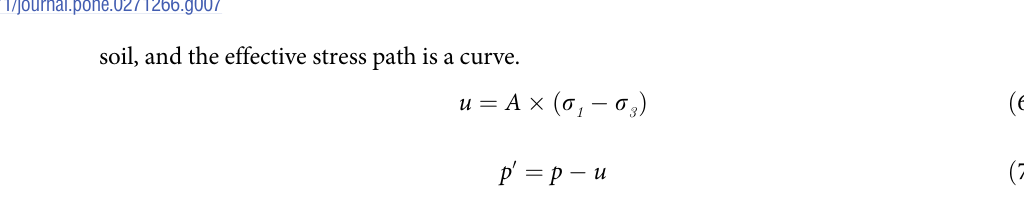
Fig 7. The relation between deviatoric stress and shear rate under different confining pressures. (a) ρ g/cm 3